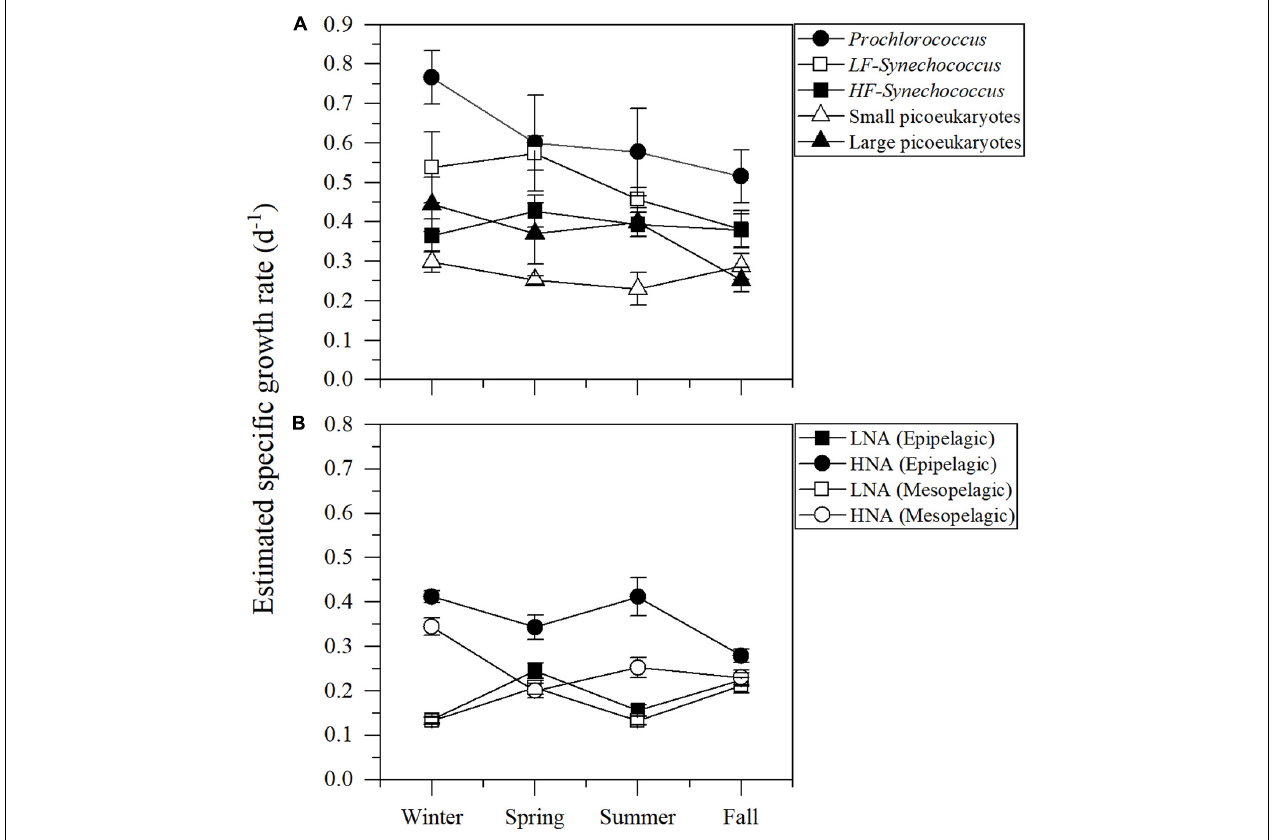
FIGURE 7 | Depth-weighted averages of the estimated specific growth rates of autotrophic picoplankton groups for the upper 100 m (A) and heterotrophic prokaryotes for the epi- (0–200 m) and mesopelagic (200–700 m) layers (B)